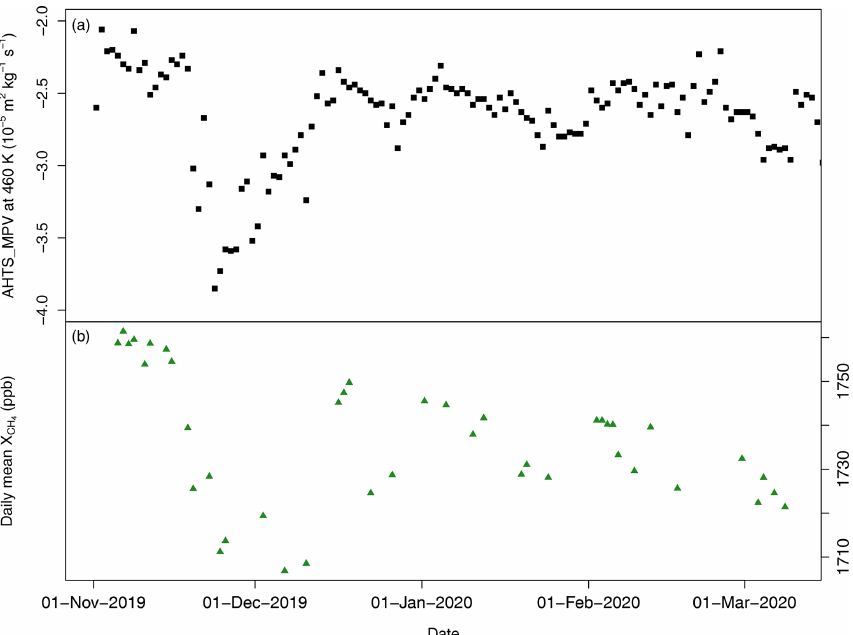
retrieved during the period of the EM27/SUN deployment at Arrival 4